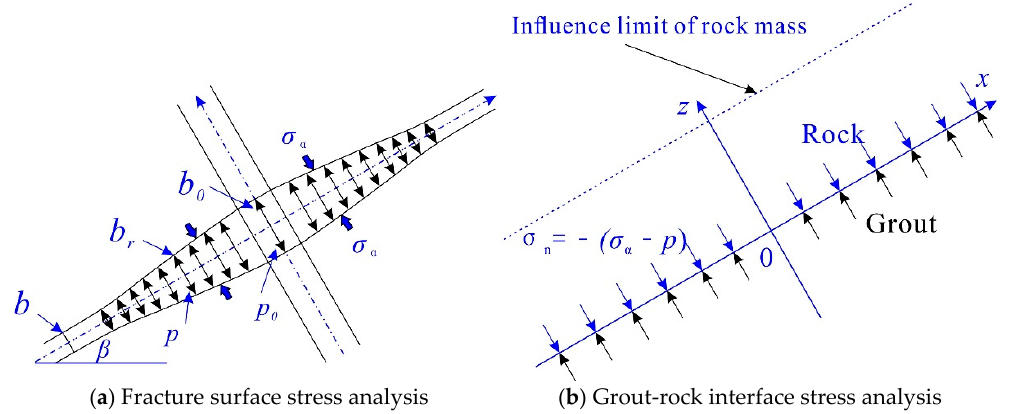
Figure 2. Schematic diagram of the force distribution on the fracture surface.